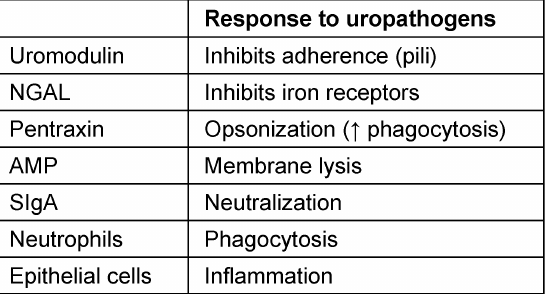
Table 2: Partial list of representative soluble factors and